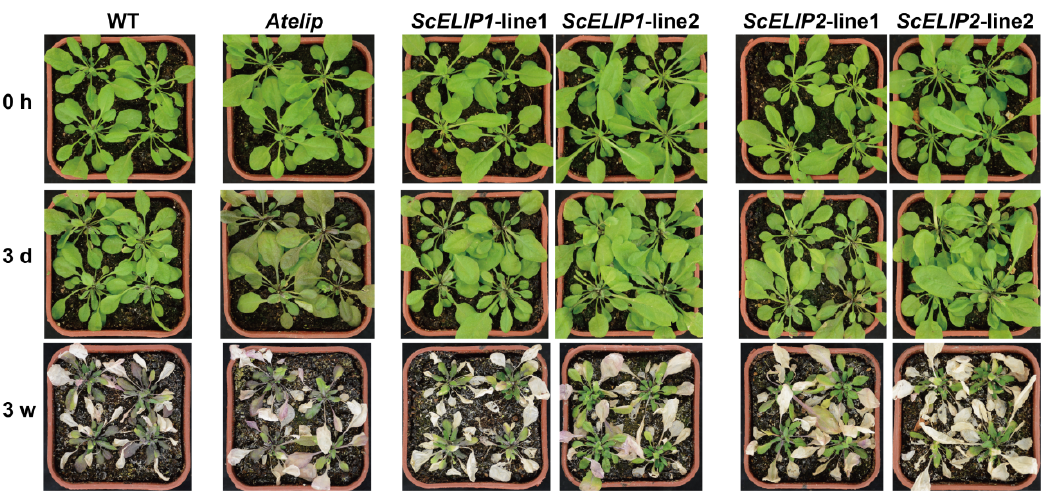
Figure 6. Phenotypic response to high-light exposure for Col-0 WT, Atelip , and 35S-ScELIP1, and 35S-ScELIP2 plantlets. Four-week old Arabidopisis lines prior to high-light irradiation treatment (Row 1), at 3 days of high-light irradiation (1000 μ mol/m 2 /s) treatment (Row 2), and 3 weeks of continuous high-light irradiation (1000 μ mol/m 2 /s) (Row 3).